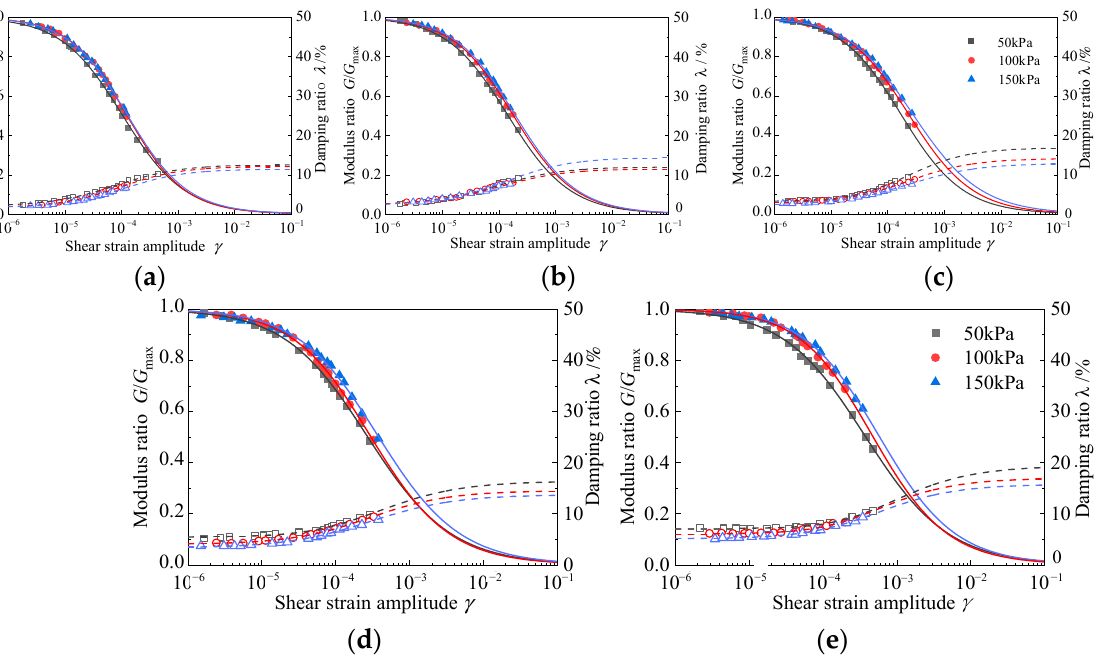
Figure 25. The G / G max ~ γ and λ ~ γ curves of the RCS soil under different confining pressures. ( a ) C = 3.5 g/100 mL, X = 10%, ( b ) C = 3.5 g/100 mL, X = 20%, ( c ) C = 3.5 g/100 mL, X = 30%, ( d ) C = 3.5 g/100 mL, X = 40%, ( e ) C = 3.5 g/100 mL, X =